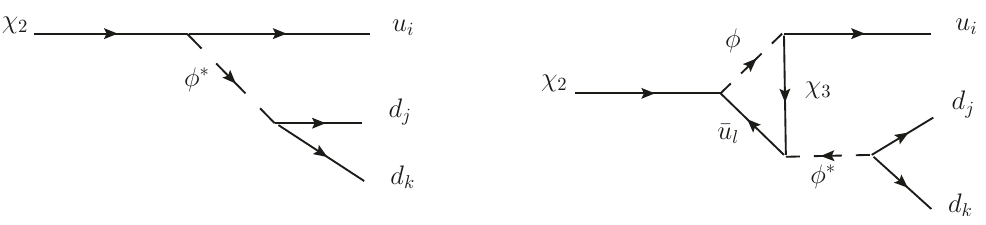
Figure 5 . Tree-level and one-loop diagrams contributing to CP violation in χ 2